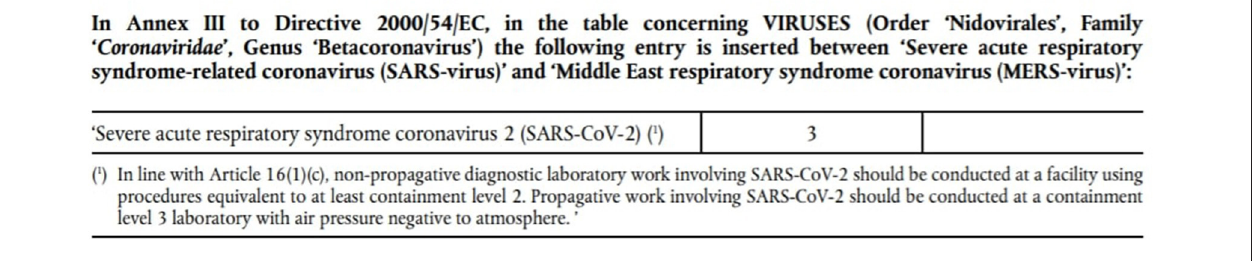
FIGURE 1 | Annex to the new Commission Directive (EU) 2020/739 of 3 June 2020.